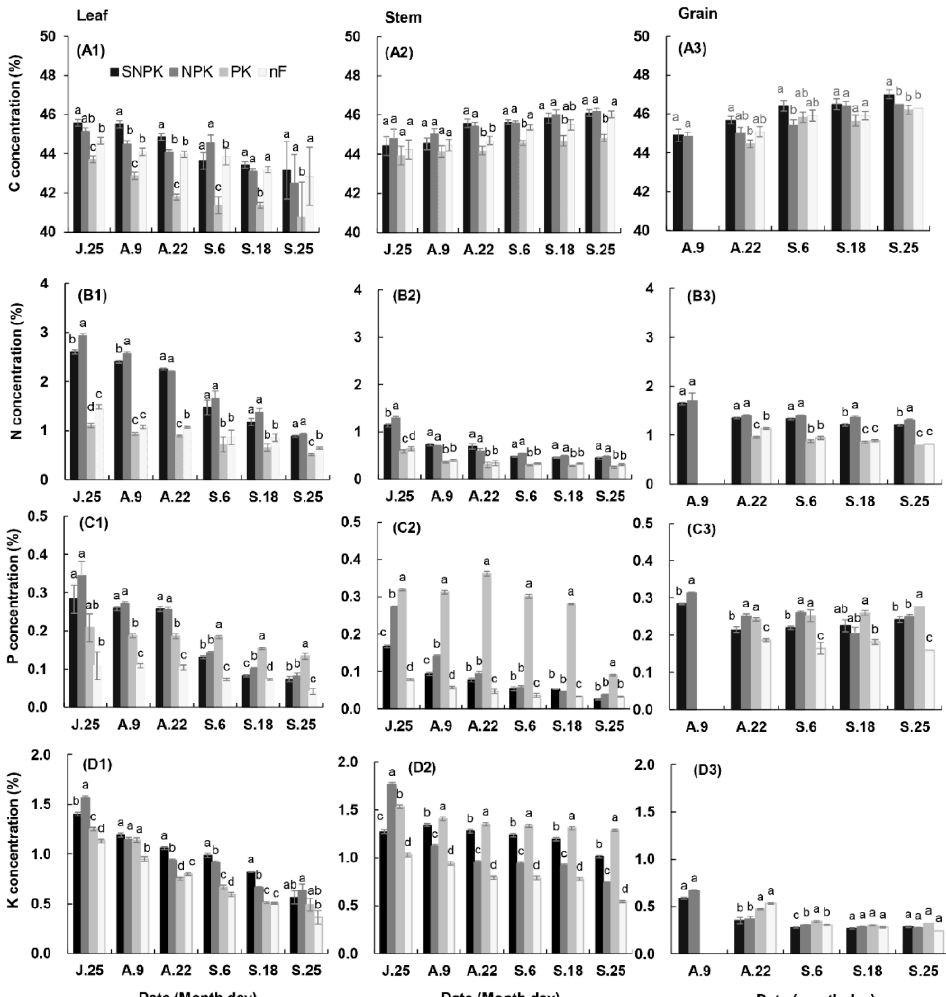
Figure 5. C, N, P, and K concentrations post-flowering in the leaf, stem, and grain in 2017 as the effect of long-term fertilizer treatment SNPK, NPK, PK, and nF. SNPK represents a combination of maize straw, chemical nitrogen, phosphorus, and potassium, NPK represents the treatment of chemical nitrogen, phosphorus, and potassium, PK represents chemical phosphorus and potassium, and nF represents no fertilizer. Values with the same letter are not significantly different at p < 0.05, comparison within the same measuring date. Bars: Standard error of the mean.